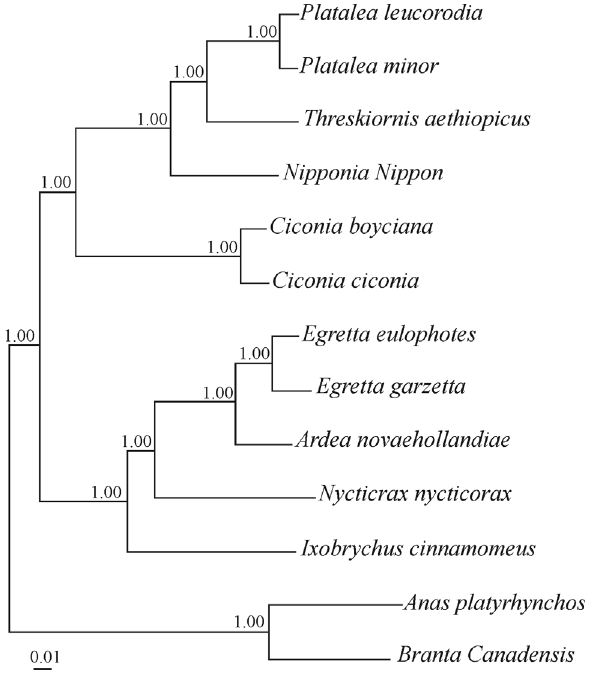
Figure 3 - Bayesian tree based on the complete mitochondrial genome data and 13 PCGs with the GIR+I+G model. The horizontal length of each branch corresponds to the substitution rates estimated with the model. Anas platyrhynchos and Branta canadensis were used as outgroups. Num- bers on the branches are the bootstrap values for Bayesian posterior proba-